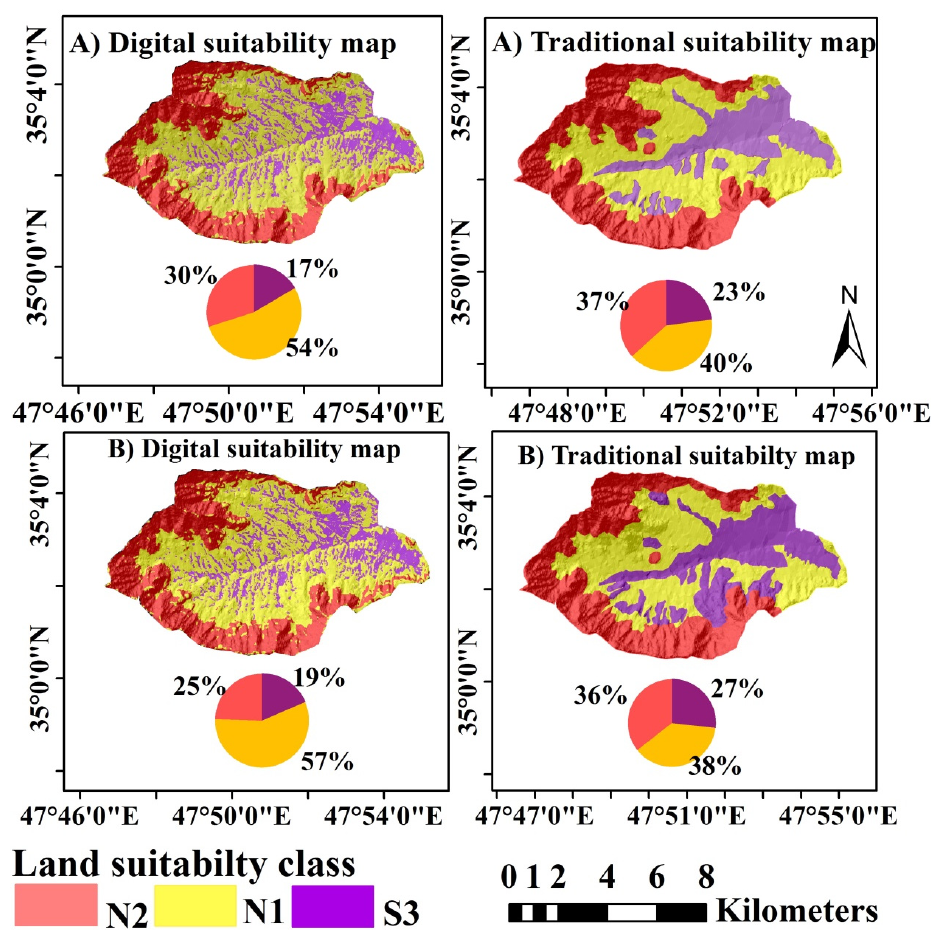
Figure 5. ML-based and traditional maps of ( A ) rain-fed wheat land suitability class and ( B ) barley land suitability class based on random forest model.